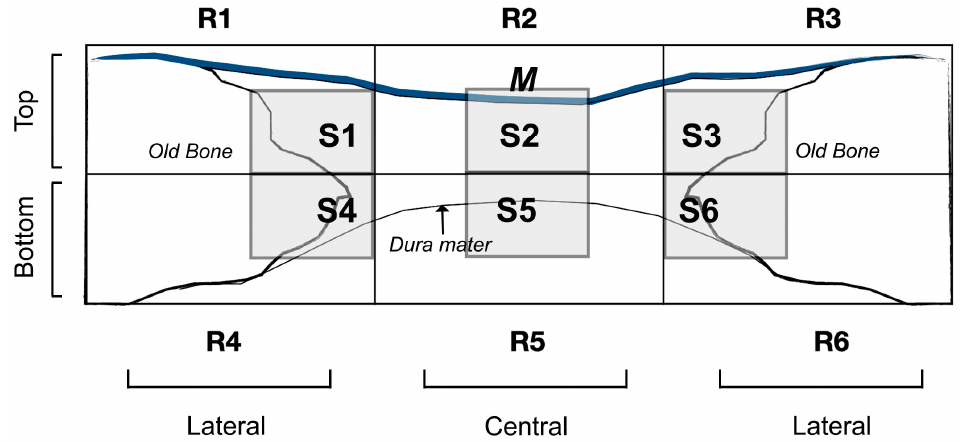
Figure 1. Schematic diagrams showing the defect and the area of measurements for histology. A software rectangular grid consisting of six regions covered the entire area of the defect. Top (close to the membrane (M) area) (R1, R2 and R3) and bottom (close to the dura mater ) (R4, R5, R6) areas are also represented. Lateral or peripheral (adjacent zone to the old bone or native calvarial) (R1, R3, R4 and R6) and central (sum of the remaining areas) (R2 and R5) zones are also represented. Six sections (S1 to S6) for analysis within each region were segmented.